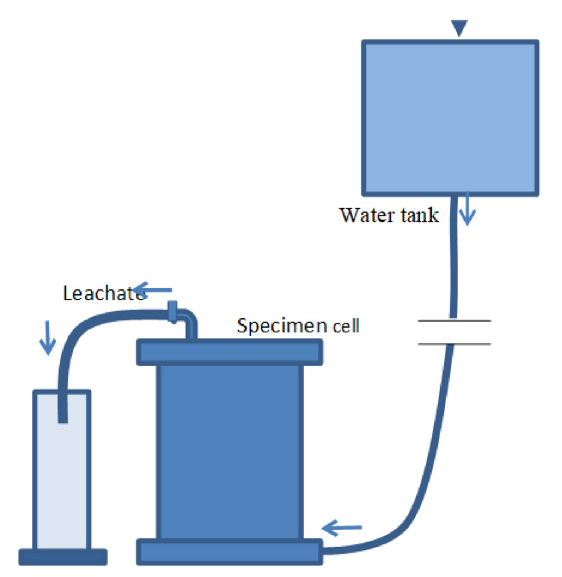
Figure 1. Seepage test